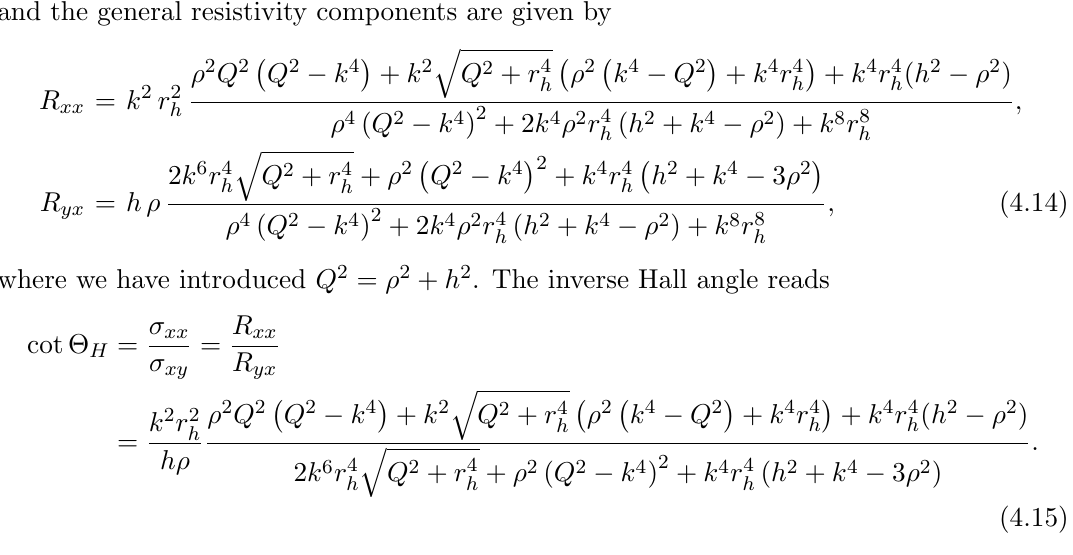
p (cid:26) = 1. In the right panel, the curves from top to bottom